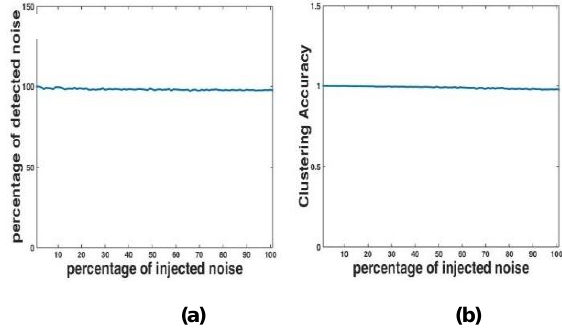
Figure 16. Performance of the algorithm to find noisy data and outliers, while keeping a high accuracy. a) The percentage of detected noise vs. the percentage of injected noise. b) Clustering accuracy vs. the percentage of injected